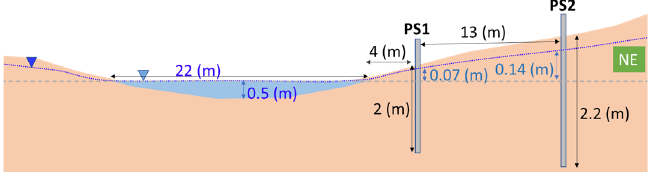
Figure 11. Cross section of Sainte-Marguerite River at location of piezometers. Water 2023 , 15 , x FOR PEER REVIEW